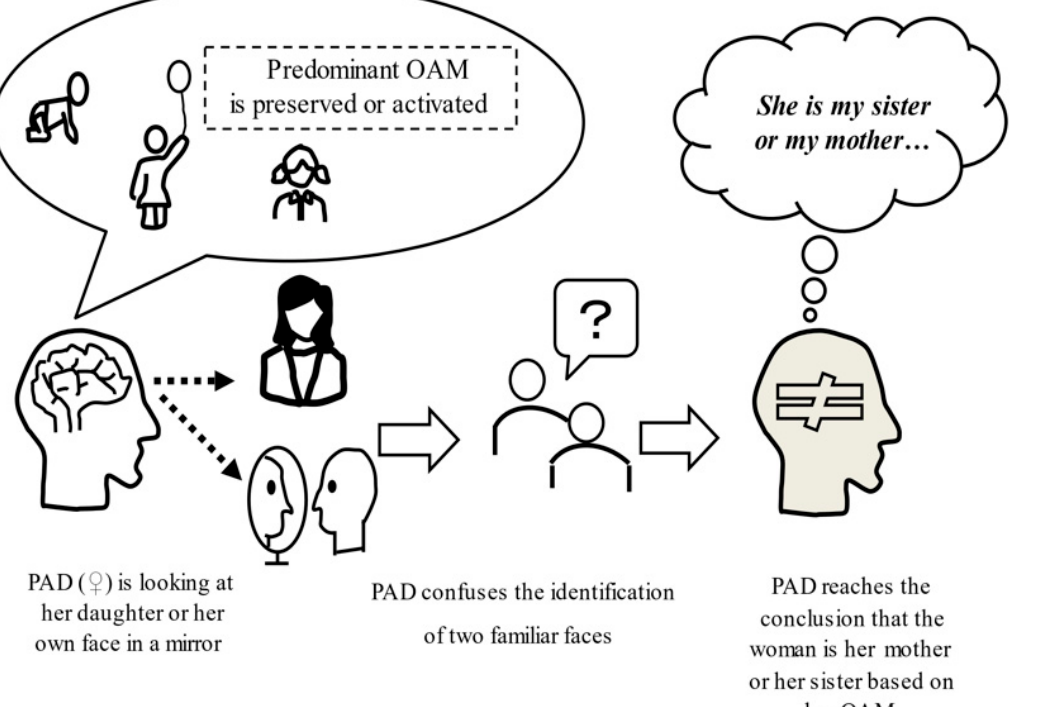
Figure 4. The predominance of OAM can cause delusional misidentifications. If preserved OAM are activated by cognitive enhancers or emotional enhancements, patients with AD may believe that their actual daughter or their own mirror image is their mother or sister as a result of the misidentification of a familiar face (their daughter or their own face) with an old familiar face (their mother or sister). Abbreviations : OAM: old-autobiographical memory, PAD: patient with Alzheimer’s dis- ease.